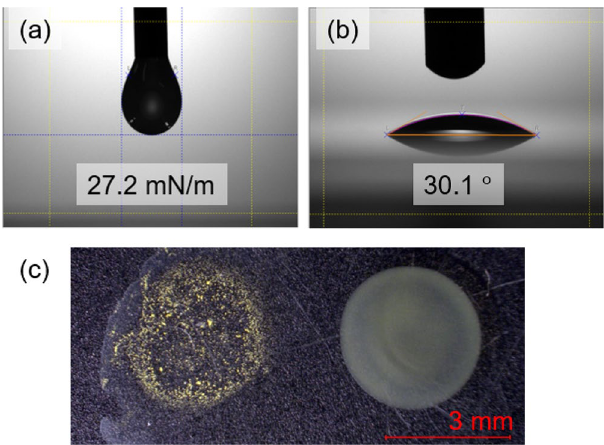
Figure 5. Photographs of ( a ) surface tension and ( b ) contact angle measurements. ( c ) Tests for the coffee ring effect (left: only FA in ethanol; right: formulated